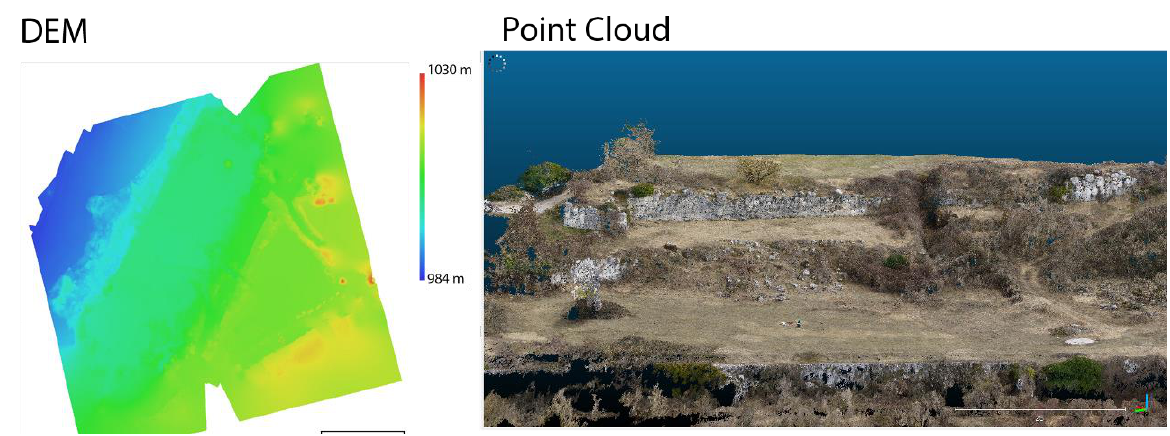
Figure 8. Output of UAV photogrammetry Survey: DEM and Point Cloud.